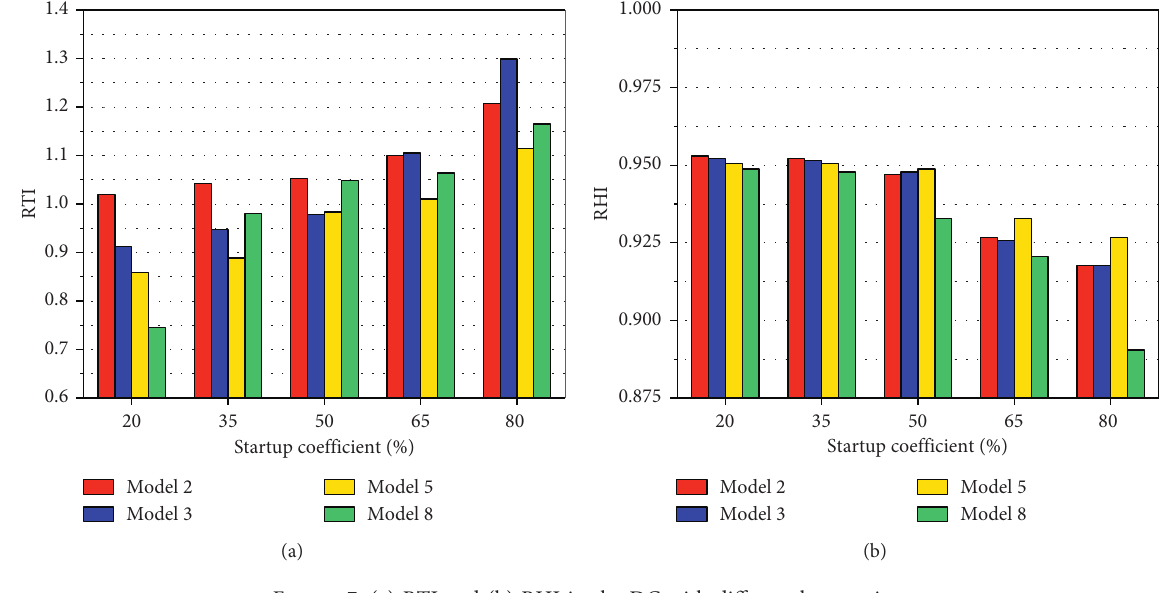
Figure 7: (a) RTI and (b) RHI in the DC with different busy ratios.